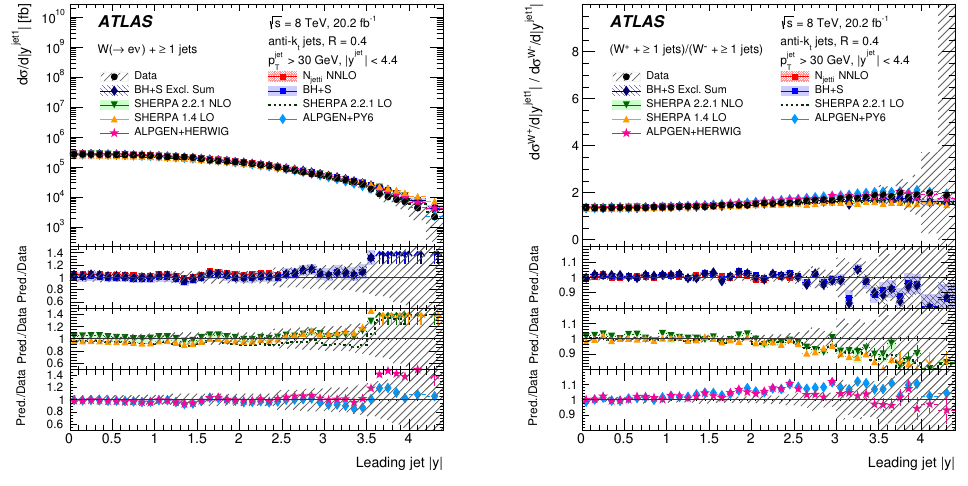
Figure 6 . Di(cid:11)erential cross sections for the production of W bosons (left) and the W + =W (cid:0) ratio (right) as a function of the leading jet rapidity for events with N jets (cid:21) 1. For the data, the statistical uncertainties are indicated as vertical bars, and the combined statistical and systematic uncertain- ties are shown by the hatched bands. The uppermost panel in each plot shows the di(cid:11)erential cross sections, while the lower panels show the ratios of the predictions to the data. The theoretical uncertainties on the predictions are described in the text. The arrows on the lower panels indicate points that are outside the displayed